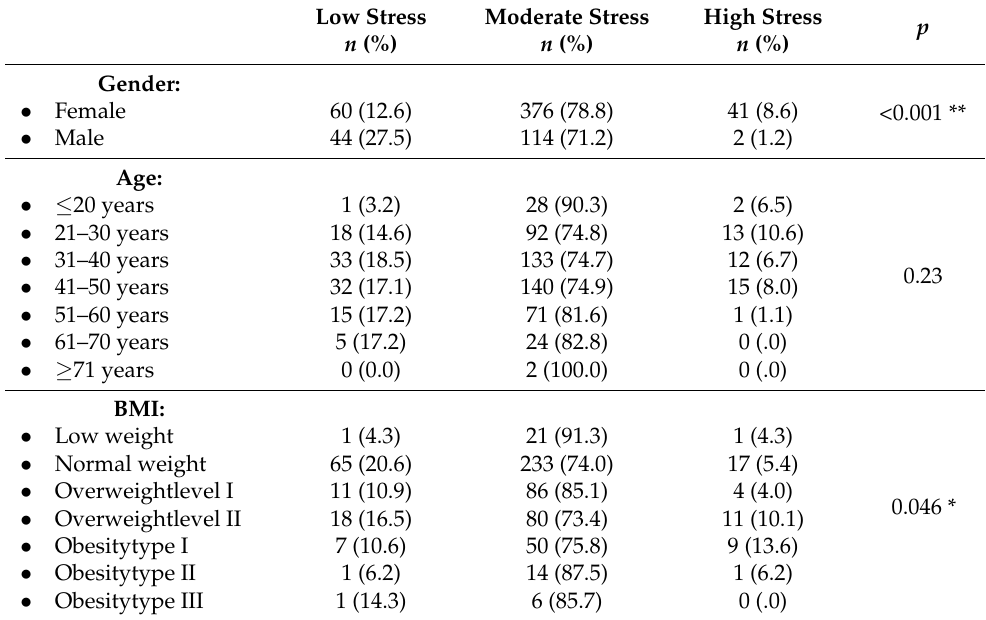
Table 2. Assessment of perceived stress during the “third wave”. Low Stress Moderate Stress